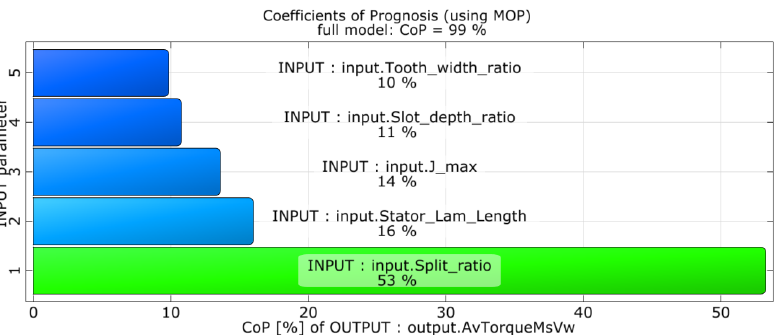
Figure 10. Example of torque response coefficient of